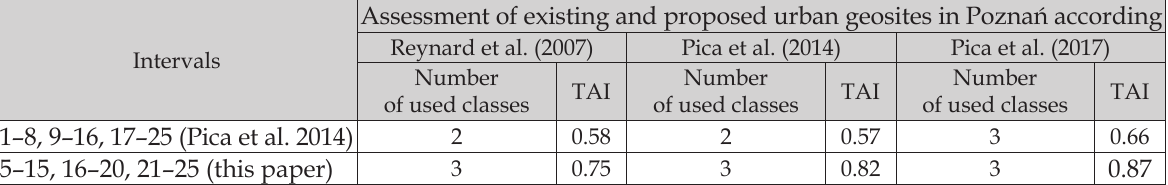
Fig. 15. Comparison of assessments for existing (A) and proposed (B) urban geosites in Poznań obtained from three methods by different Table 1. Effectiveness of class spanning in urban geosites assessment on the basis of the Tabular Accuracy Index (TAI) according to formula by Jenks and Caspall (1971).